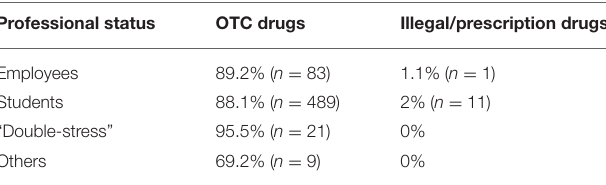
TABLE 3 | Use of OTC an illegal/prescription drugs according to the professional status ( n =